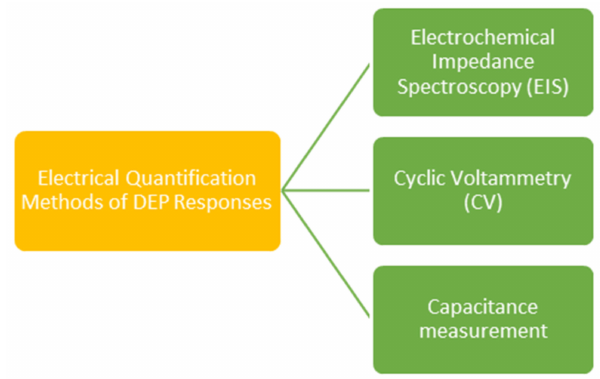
Figure 6. Electrical quantification methods for identifying DEP